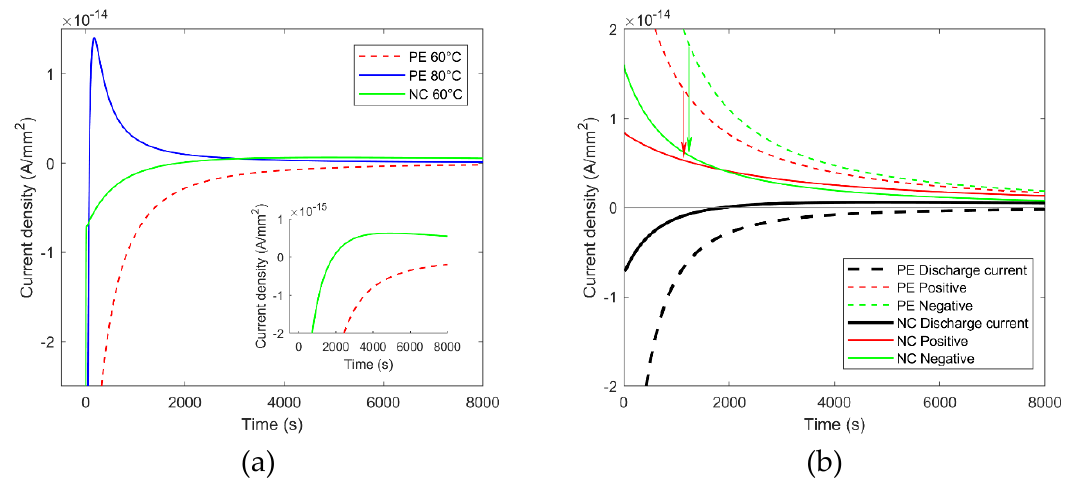
Figure 9. ( a ) Simulated discharge currents in studied materials at di ff erent temperatures. The inset displays the magnification of the plot including discharge currents at 60 ◦ C. ( b ) Magnitude of simulated positive and negative current components in studied materials at 60 ◦ C. Arrows indicate the reduction in magnitude of the current components due to the suppression of electrical conduction in the